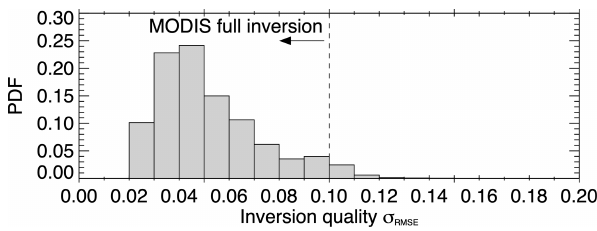
Figure 5. Statistics of the quality of the inversion. RMSE of all airborne retrievals (PDF; bin size: 0.01). Vertical dashed line shows RMSE threshold of 0.1 for MODIS full